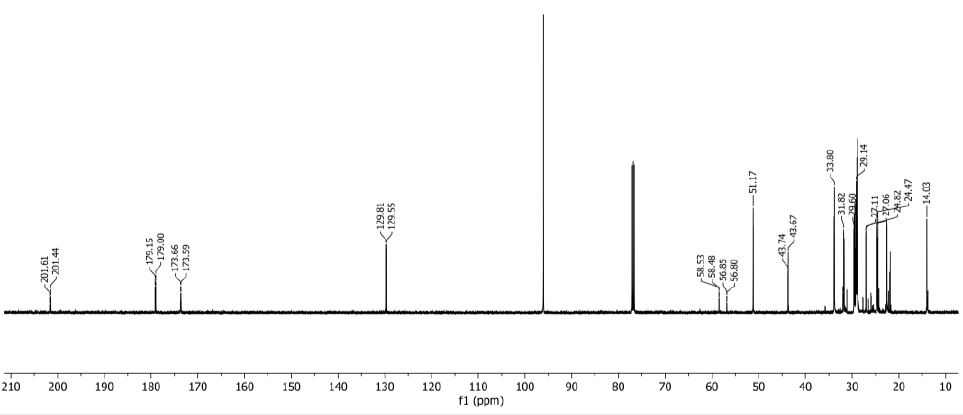
Figure 14. 13 C NMR spectrum for oxidized canola FAME product.